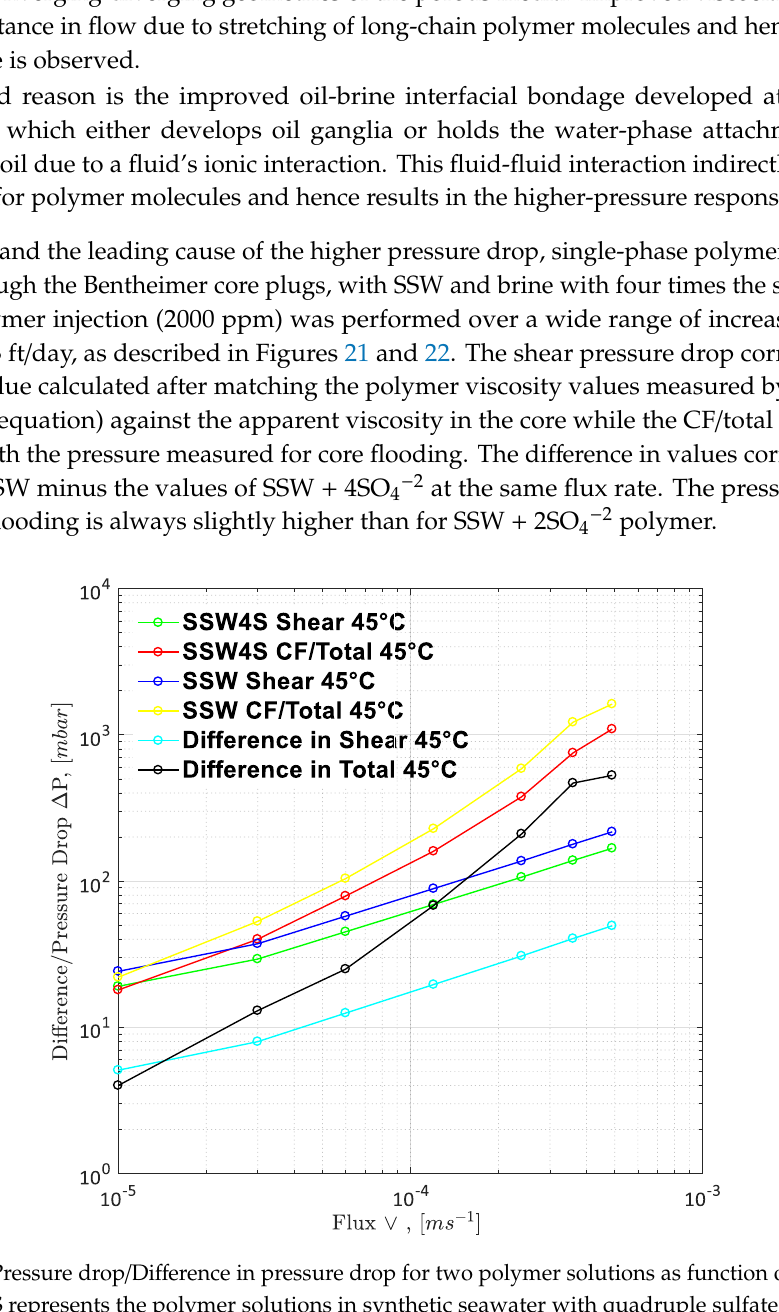
Figure 22. Pressure ratio as function of flux rate (two polymers). SSW4S represents the polymer solutions in synthetic seawater with quadruple sulfates and SSW denotes polymer solutions in synthetic seawater. Pressure ratio is defined as the polymer pressure drop at each flux rate divided by pressure drop for brine flood at flux rate of 10 feet/day. Moreover, the difference in pressure drop remained constant for all flux values with the same trend line. The pressure ratio presented in Figure 21 indicates that polymer-SSW presented higher values than polymer-SSW + 4SO 4−2 (flux rate higher than 1 × 10 −4 m/s). At flux values higher than 1 × 10 −4 m/s, the slope of both polymer solutions increased due to the dominance of viscoelastic response. However, this dominance was observed for both polymer solutions. This justifies that a spiked amount of sulfates cannot improve the viscoelastic response of polymer solutions, while flowing through porous media. Further, increased sulfates make polymer solution sensitive to mechanical